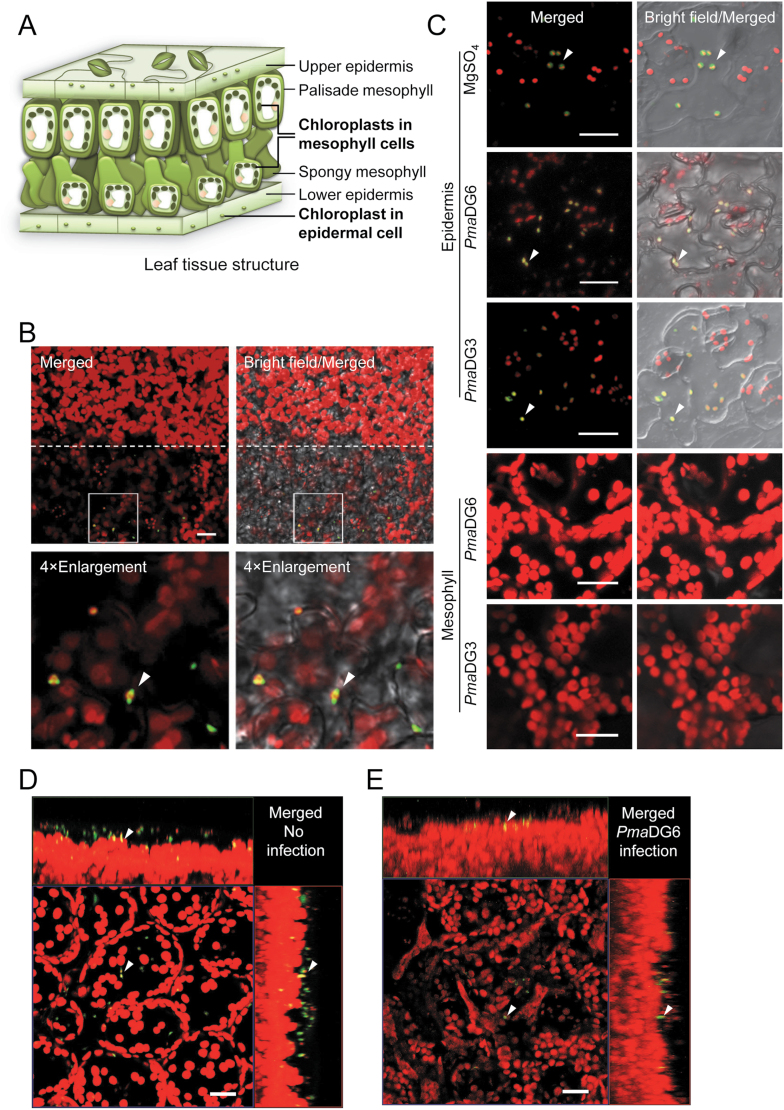
Epidermal cell-specific accumulation of ALD1:GFP fusion proteins after DEX treatments of leaves with or without infection. (A) Diagram of leaf structure and chloroplasts in different cell types. The size of chloroplasts in upper and lower epidermal cells is much smaller than that of the chloroplasts in mesophyll cells. (B–E) Laser scanning confocal micrographs of DEX-induced ALD1:GFP fusion protein in leaves of Arabidopsis transgenic lines pDEX::ALD1 #6 or #10. GFP fluorescence is shown in green and chlorophyll autofluorescence is shown in red. Scale bar=20 μm. (B) Expression and localization of DEX-induced ALD1:GFP fusion protein in the abaxial side of a half peeled leaf in pDEX::ALD1 #10. Above the dotted line are the mesophyll cells after removing the lower epidermis, while the part below is the original leaf with epidermis. Leaves were soaked in 30 μM DEX for 2 d before peeling. Four times (4×) enlarged images of selected insets are shown in the lower panels. Single layer scanning images were used. Similar results were observed in three independent experiments (n≥6 biological replicates for each experiment). (C) ALD1:GFP fusion protein in the epidermis or mesophyll of line pDEX::ALD1 #6 after pathogen Pma infection. Leaves were first sprayed with 30 μM DEX for 2 d, then inoculated by PmaDG6, PmaDG3 (OD600=0.01), or 10 mM MgSO4 for 18 h. Epidermal strips were peeled from the abaxial surface of the leaf, and the mesophyll layer was from the corresponding peeled region. Maximum intensity projections of Z-series images are used for epidermis data. Similar results were observed in two independent experiments (n≥6 biological replicates for each experiment). (D and E) Maximum intensity projections of the leaf with orthogonal projections to the XY, XZ, and YZ planes. Arrows indicate the same plastid. Leaves of line pDEX::ALD1 #6 were pre-treated with perfluorodecalin. Similar results were observed in two independent experiments (n≥6 biological replicates for each experiment). (D) Leaves of a 28-day-old plant were infiltrated with 30 μM DEX for 2 d. Images were taken from the adaxial surface of the leaf before infection. (E) Leaves of a 24-day-old plant were sprayed with 60 μM DEX for 1.5 d, and then infiltrated with PmaDG6 (OD600=0.01) for 18 h. Images were taken from the abaxial surface of the leaf after infection.